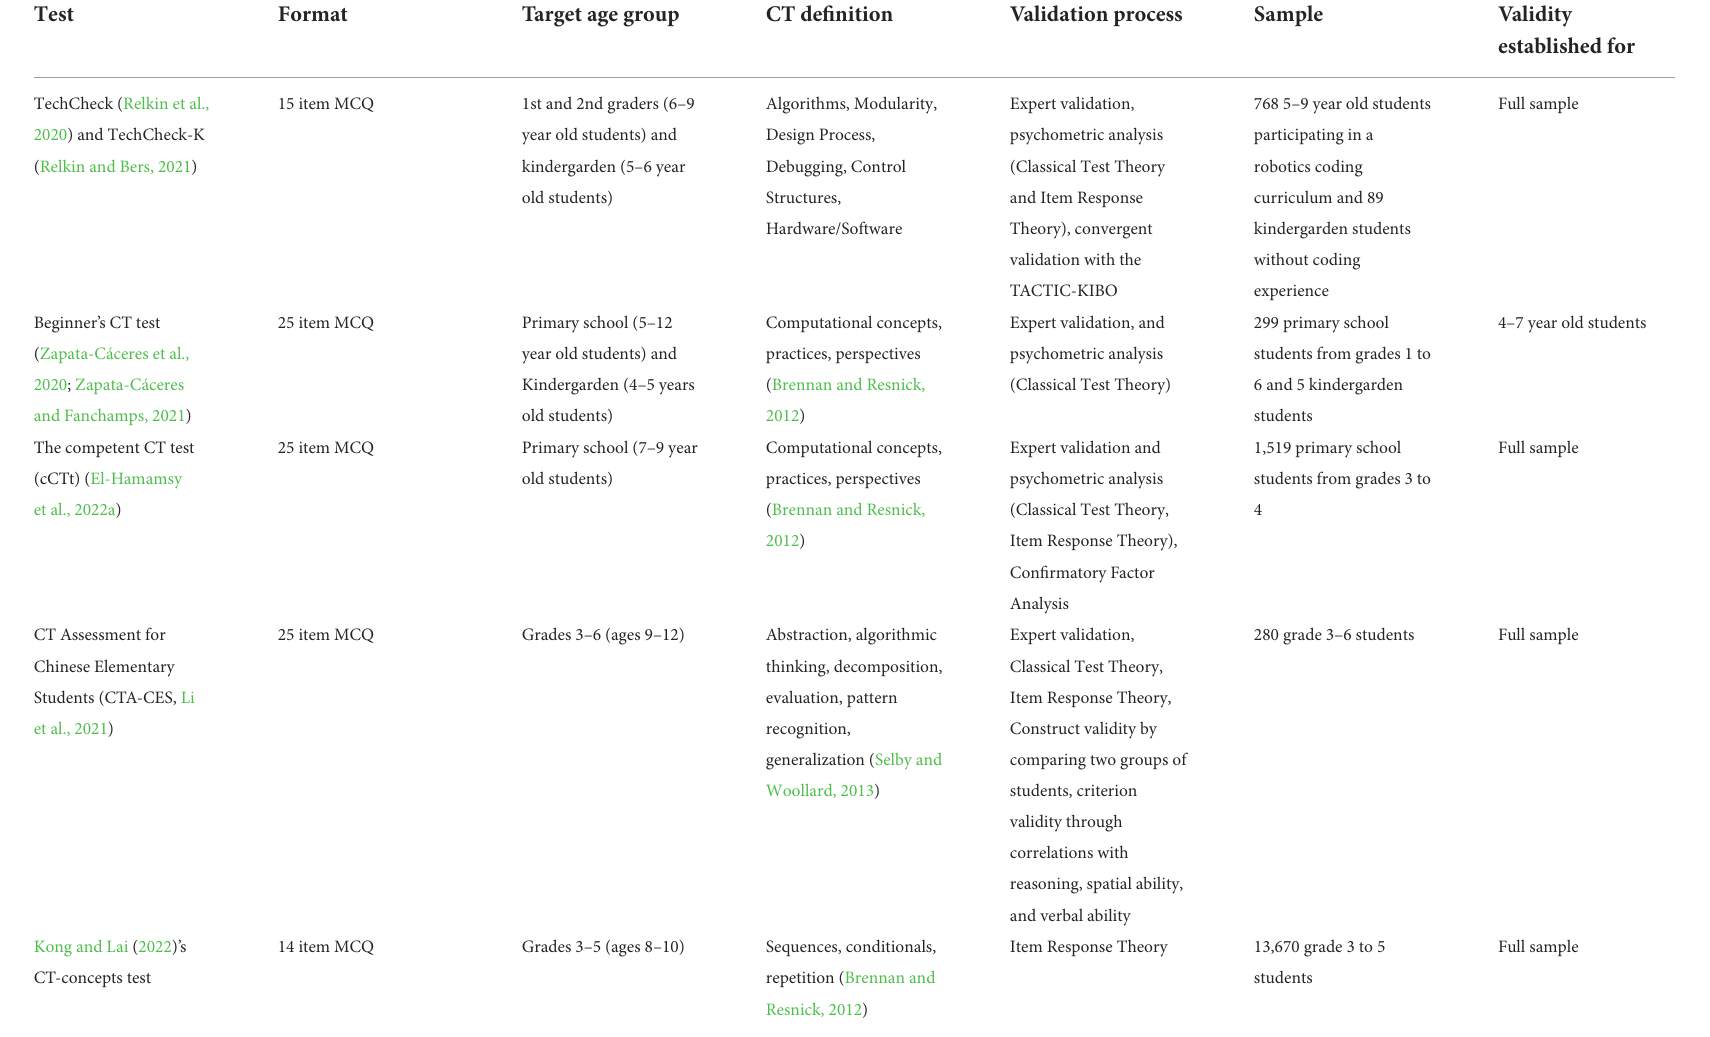
TABLE 1 Synthesis of validated and scalable primary school unplugged CT assessments and corresponding validation processes adapted from El-Hamamsy et al.